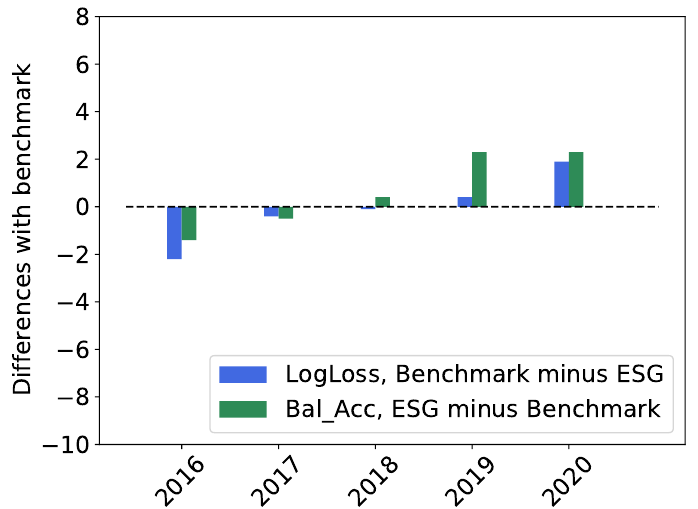
Figure 8. Performance measures in comparison to the benchmark for the company-wise 5-fold cross-validation. Bal_Acc refers to the balanced accuracy